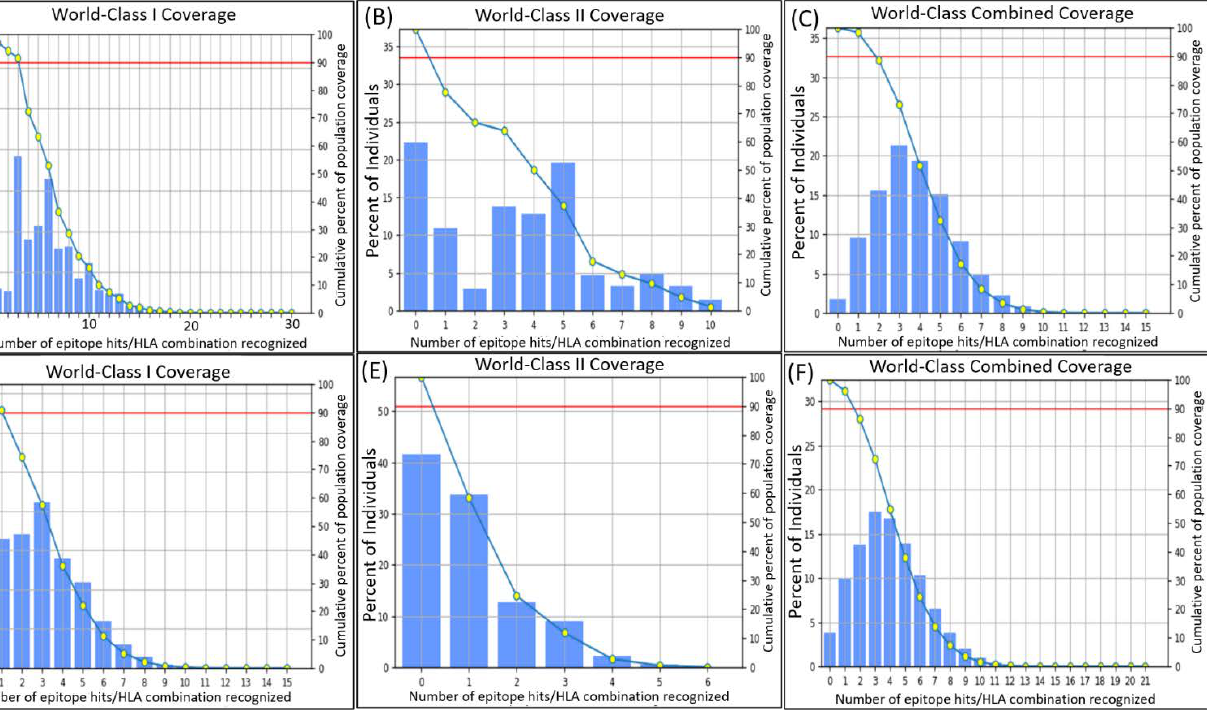
Figure 3. ( A ) World coverage of phytoene dehydrogenase’s selected epitopes for MHC-I class. ( B ) World coverage of phytoene dehydrogenase’s selected epitopes for MHC-II class. ( C ) World coverage of selected epitopes of phytoene dehydrogenase for both MHC classes. ( D ) World coverage of hypothetical protein’s selected epitopes for MHC-I class. ( E ) World coverage of hypothetical protein’s selected epitopes for MHC-II class. ( F ) World coverage of hypothetical protein’s selected epitopes for both MHC classes.